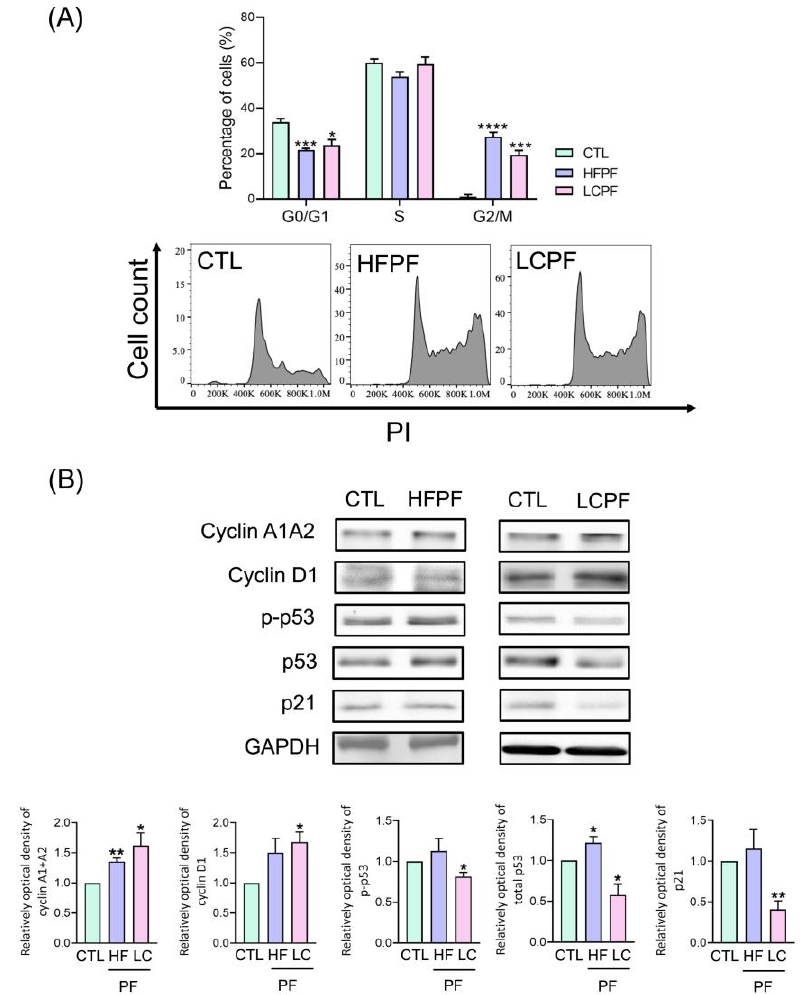
Figure 3. Effect of cell-free HFPF and LCPF on keratinocyte cell cycle regulation. HaCaT cells were treated with HFPF, LCPF, or the control medium for 24 h. ( A ) Flow cytometry was then performed to analyze cell cycle expression. Quantification of cell cycle populations in the G0/G1, S, and G2/M phases was analyzed using BD FACSuite software. ( B ) Protein expression of cyclin A1A2, cyclin D1, p -p53, p53, p21, and GAPDH in HaCaT cells. The lower panels show the quantitative analyses of Western blotting. * p < 0.05; ** p < 0.01; *** p < 0.005; **** p < 0.0001 compared to the control group.